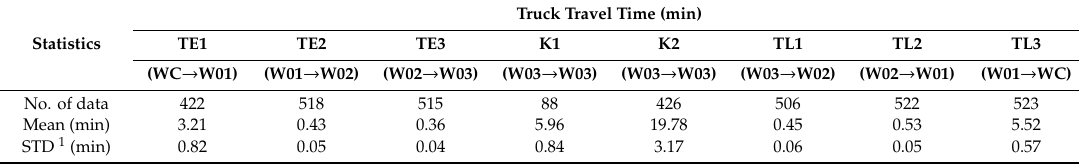
Table 5. Results of measuring truck travel time through statistical